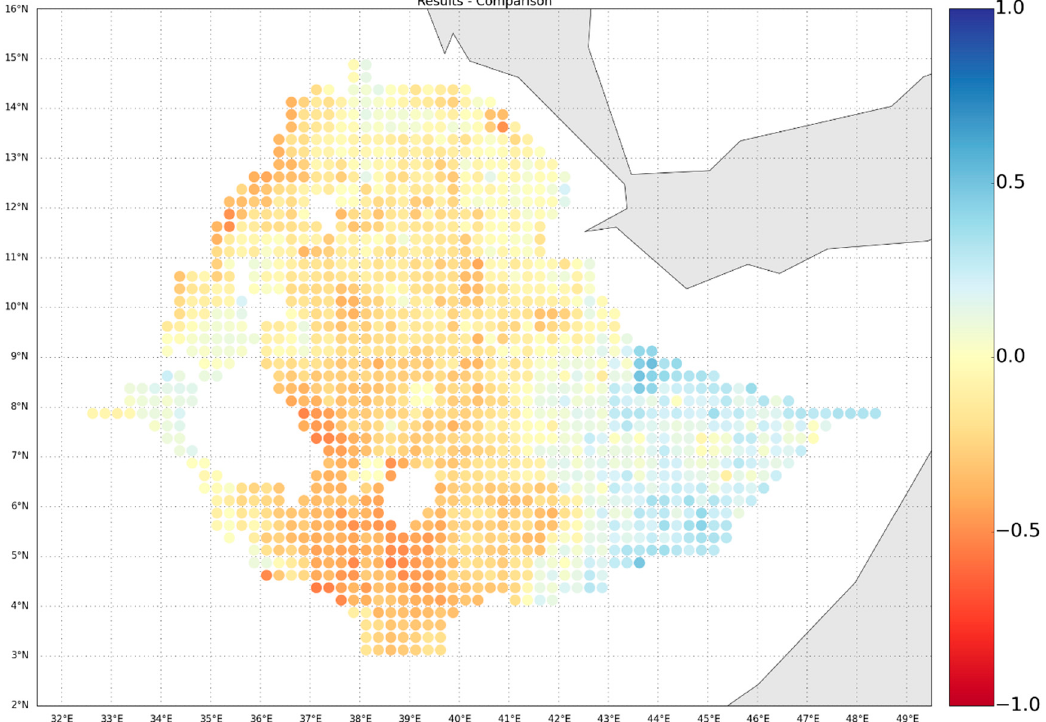
Figure 9. Comparison of ECDI warning levels and sc-PDSI for 1992–2012: average Pearson’s R : − 0.09, and average Stdv: 0.2. Regions with dense vegetation or complex topography and lakes are masked.